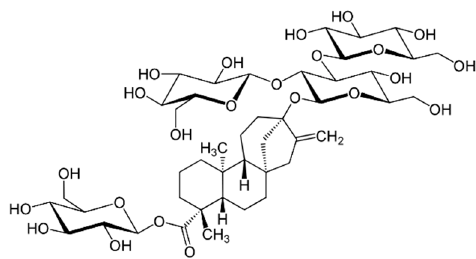
Figure 2. Structure of Rebaudioside A.